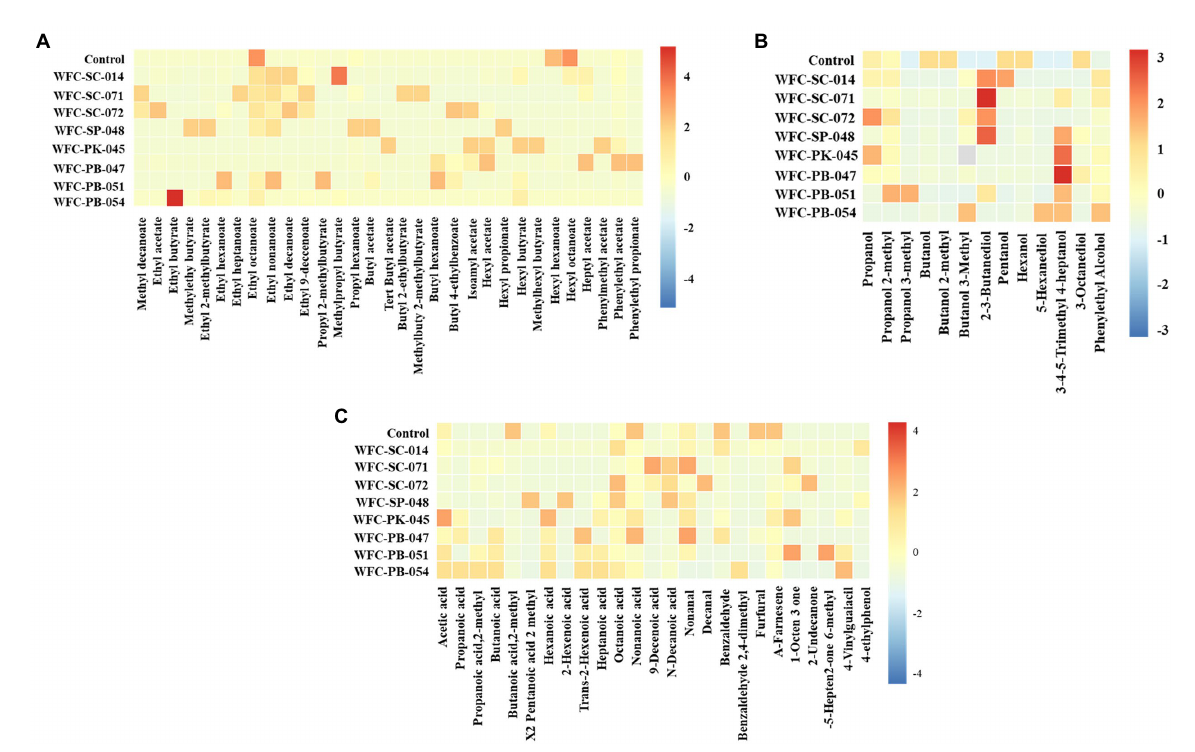
FIGURE 5 Volatile compounds of the fermented ciders. The heat map describes the aromatic compounds of ciders fermented for 7 days by eight strains. Esters (A) , alcohols (B) , and other aroma compounds (C) in fermented ciders. Aroma components changed significantly after fermentation. Aroma compounds were prominently expressed in ciders fermented by strains WFC-SC-071 and